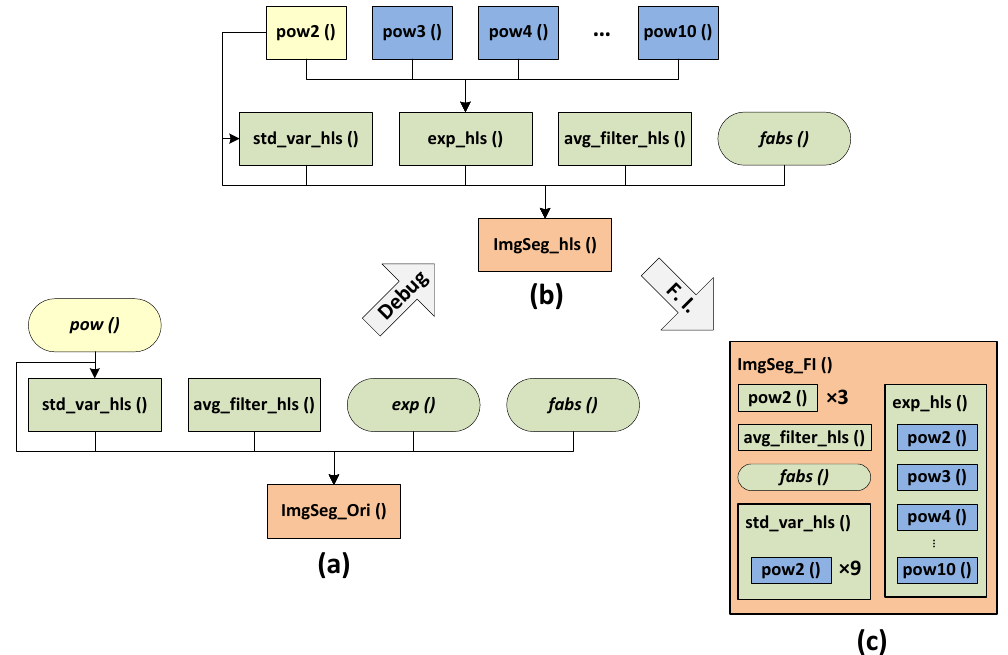
Figure 3. Block hierarchy comparison: ( a ) original version; ( b ) debugged version; and ( c ) Function Inline (FI)